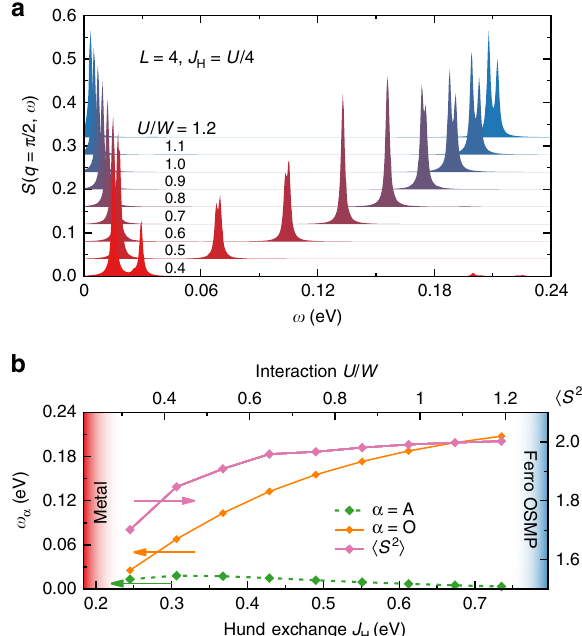
Fig. 6 Hund exchange dependence. a Dynamical SSF at q / π = 1/2 for various values of the interaction U , all within the block-OSMP phase, U / W = 0.4, … , 1.2 (bottom to top, with 0.04 offset), at a fi xed J calculated for L = 4 using the Lanczos method. b Left y -axis: Frequency ω α = ϵ − ϵ dependence of the acoustic and optical modes vs the value of α GS the Hund exchange coupling J H . Right y -axis: Magnetic moment S 2 development within the block-OSMP